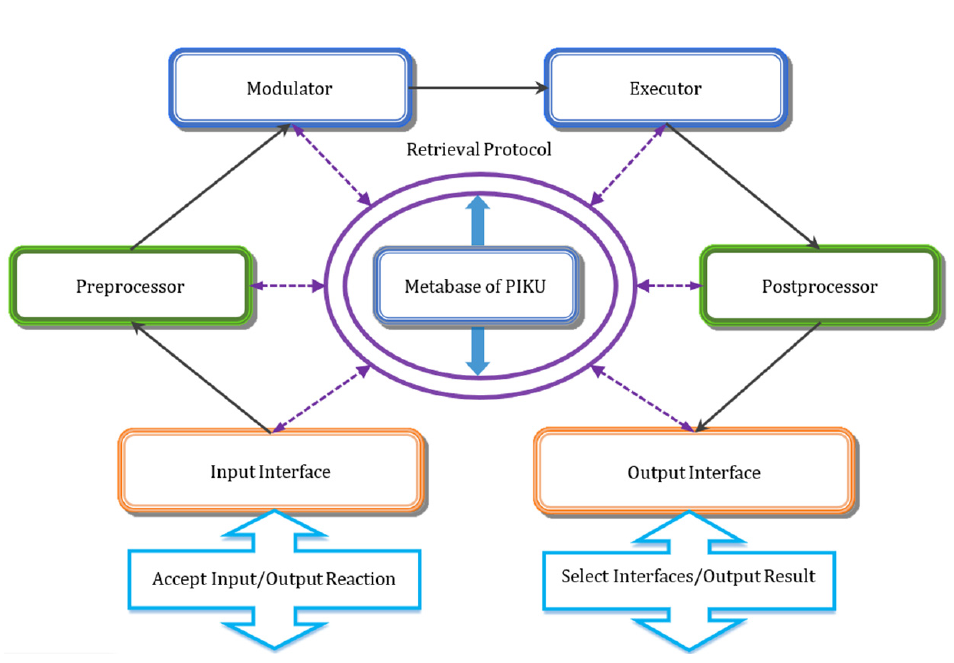
Figure 5. Knowledge processing architecture of machining